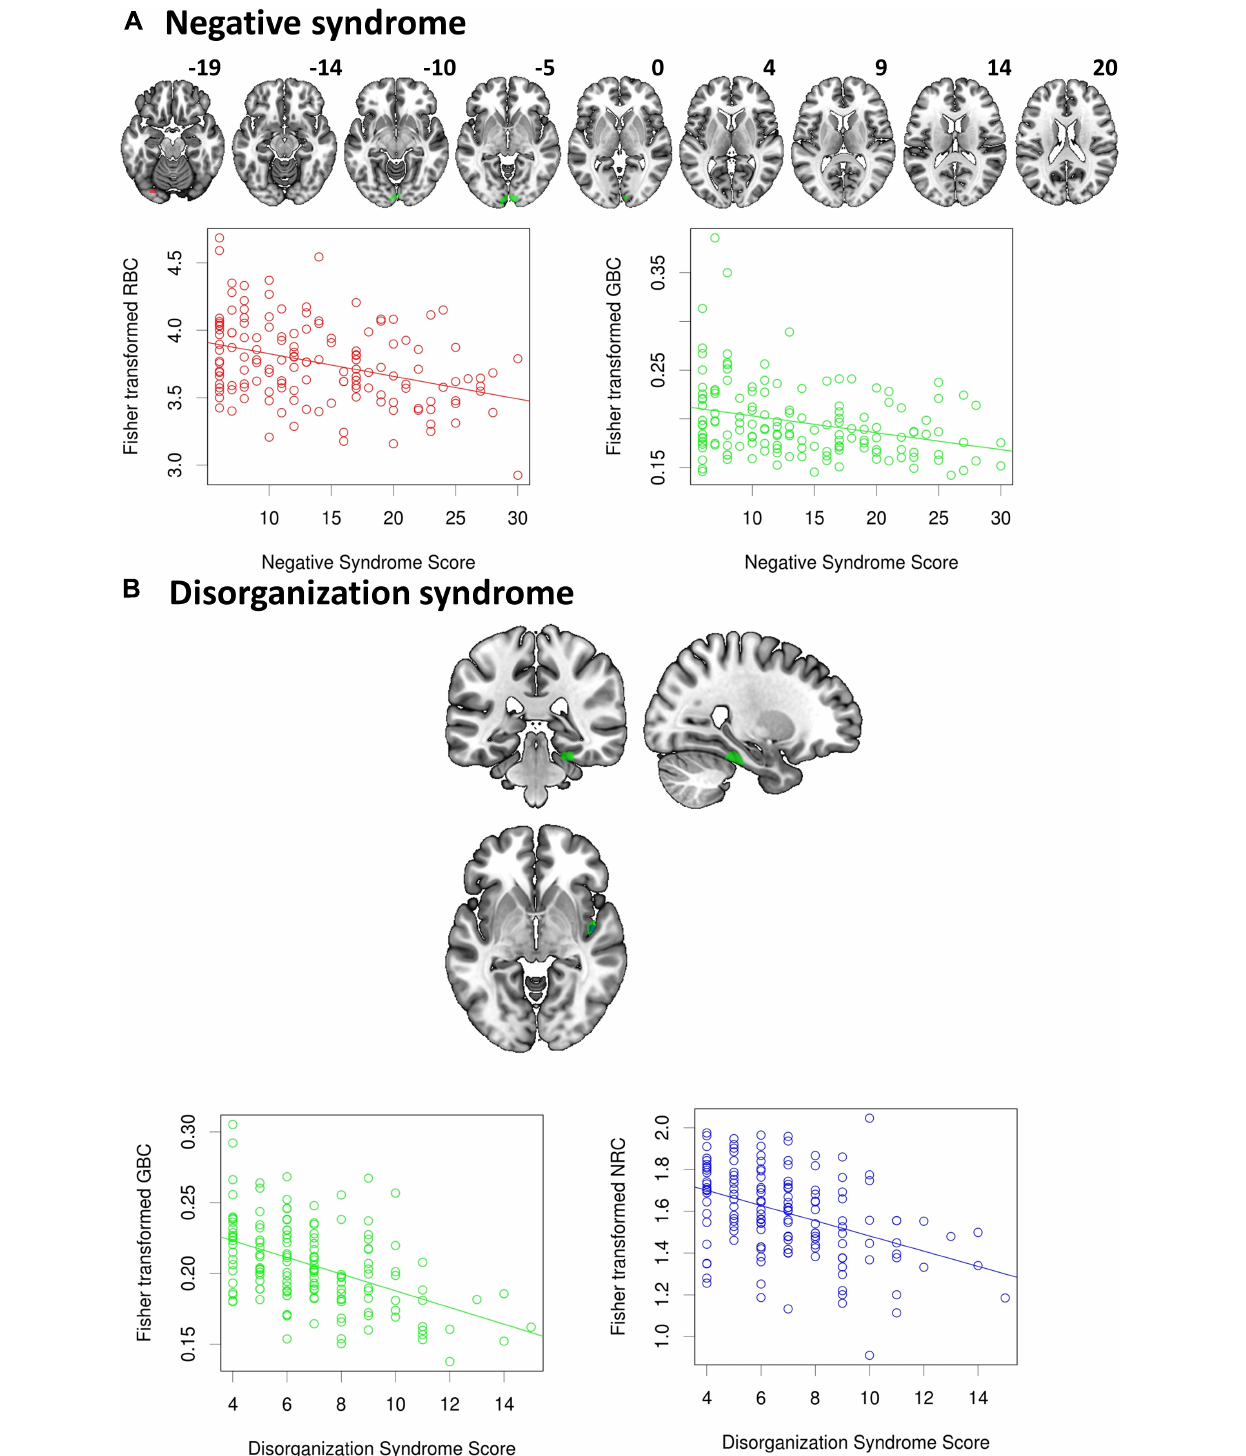
Frontiers in Human Neuroscience |